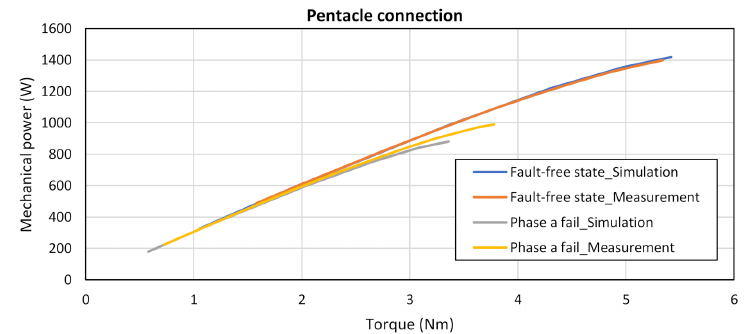
Figure 34. The dependence of the mechanical power on the torque for a fault-free state and one phase failure in the pentacle